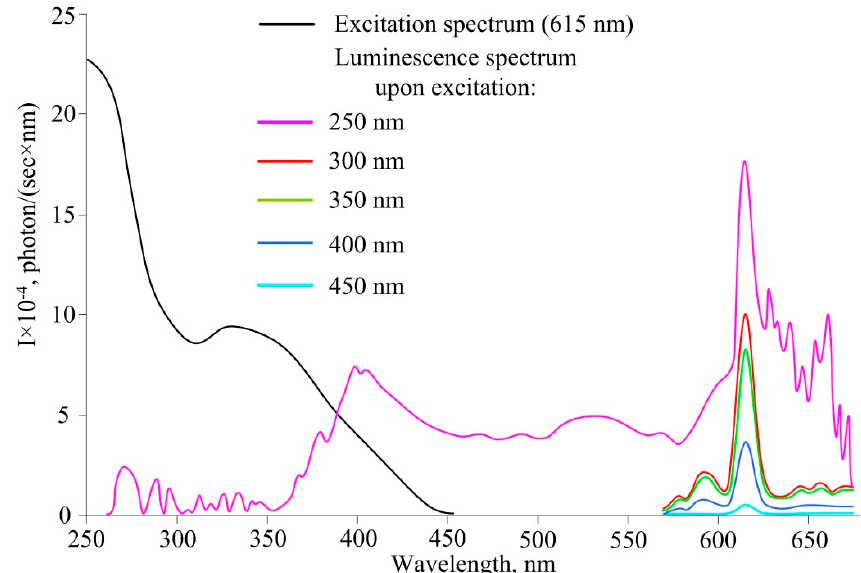
Figure 4. Excitation spectrum (recorded at 615 nm) and luminescence spectrum of compound 4 .